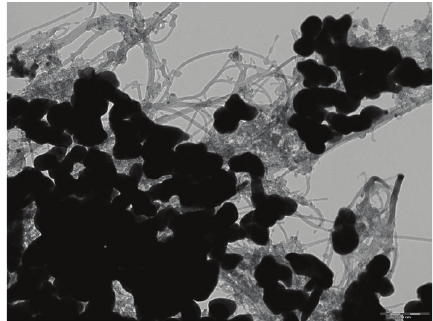
Figure 6: Transmission electron microscopy (TEM) image of poly( 𝜀 -caprolactone) (PCL) ternary nanocomposite based on SWC- NTs and Ag